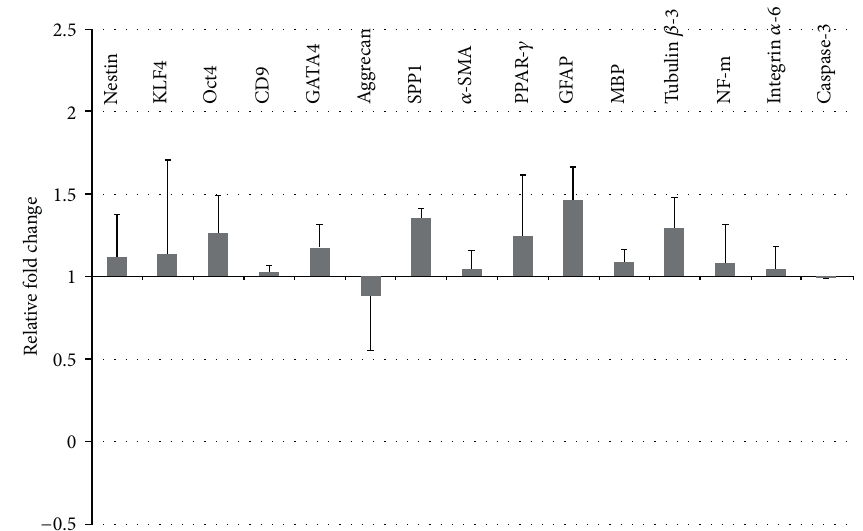
Figure 10: The transcriptional activity of QD labeled stem cells was analyzed by quantitative PCR and set in relation to untreated control approaches (representing the value “1”). Changes in gene expression are displayed as upregulation ( > 1) and downregulation ( < 1). Standard deviations were calculated from two experiments. Transcripts related to stem cells (Nestin, KLF4, Oct4, CD9), endodermal cells (GATA4), mesodermal cells (Aggrecan, SPP1, 𝛼 -SMA, PPAR- 𝛾 ), and ectodermal cells (GFAP, Tubulin 𝛽 -3, NF) were analyzed. Also the mRNA expression level of the surface protein Integrin alpha-6 and the apoptosis marker caspase-3 was